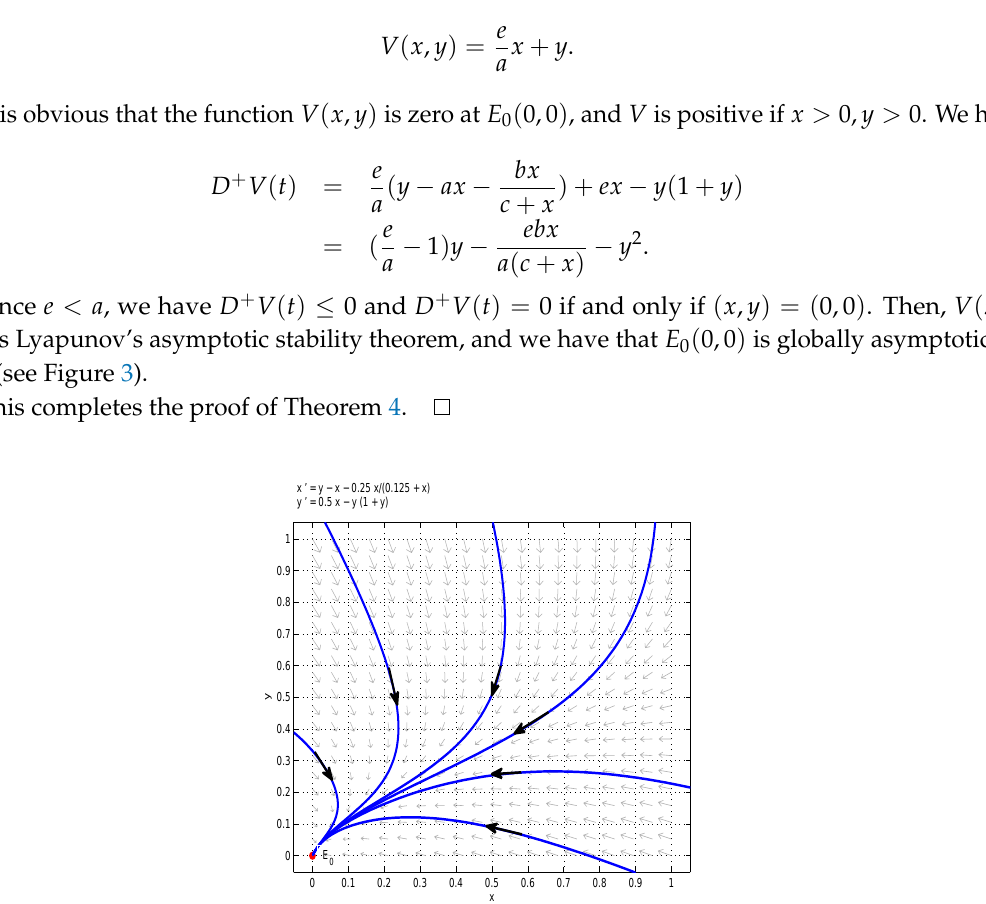
Figure 3. System (6) has no internal equilibria, and a unique boundary equilibrium E 0 is globally asymptotically